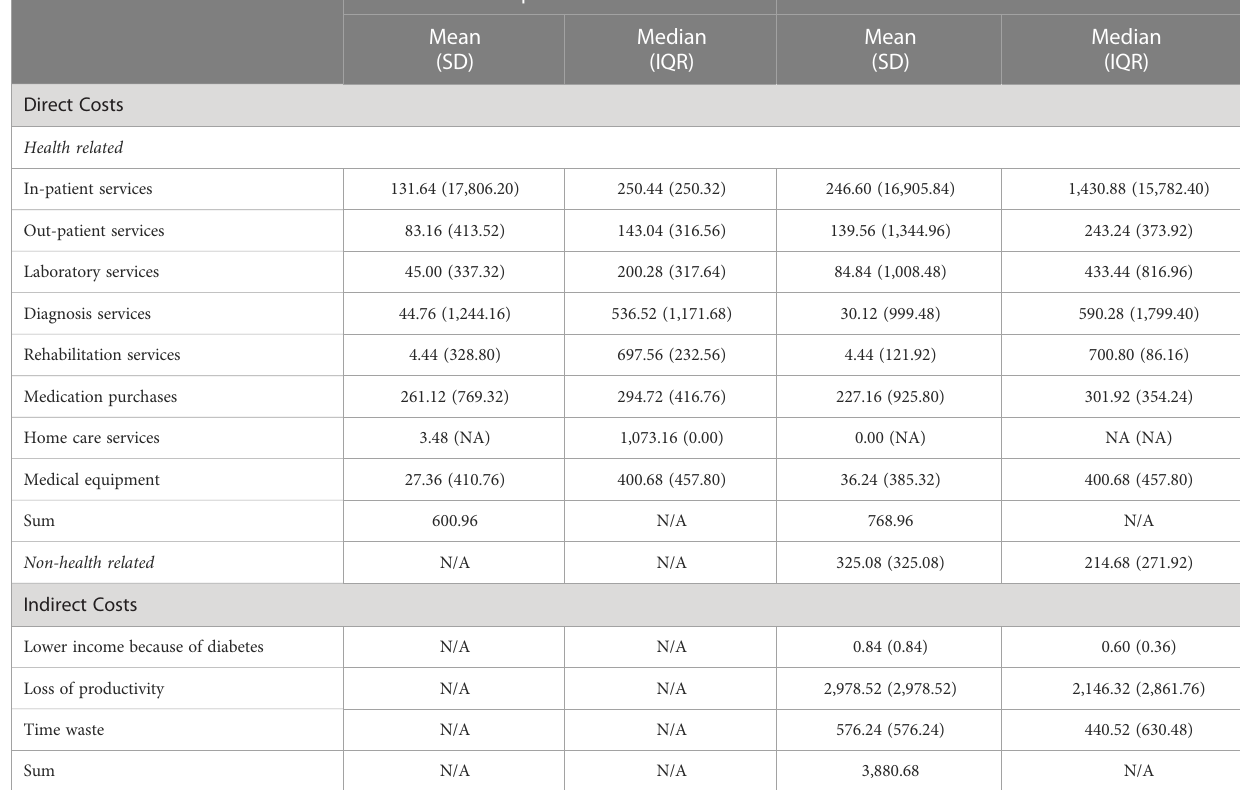
TABLE 4 Annual costs of medical services for patients with